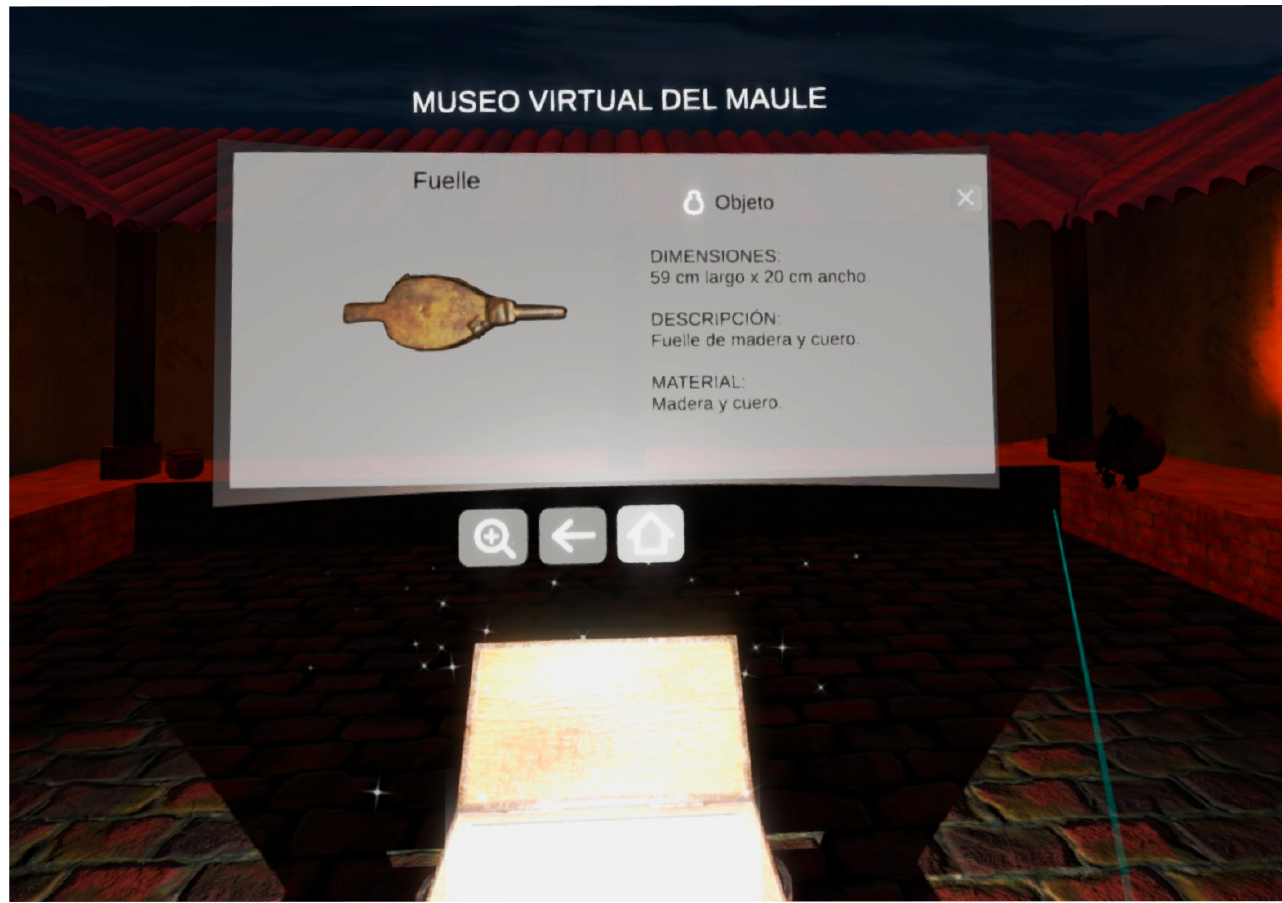
Figure 4. The panel of visualization: Interface where users can appreciate the 3D objects in 360 degrees and see all their features. In this case, a bellows with its dimensions, description, and